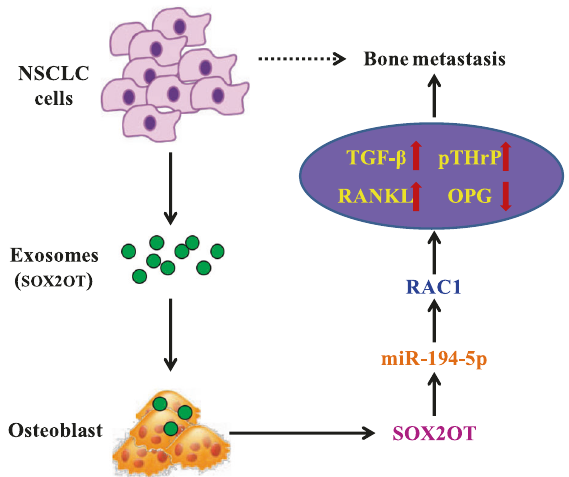
Fig. 7 Schematic diagram of this study. A schematic model showing that tumour-derived exosomal lncRNA-SOX2OT promotes the bone metastasis of the lung cancer by targeting the RAC1 signalling pathway through miRNA-194-5p in osteoclasts.